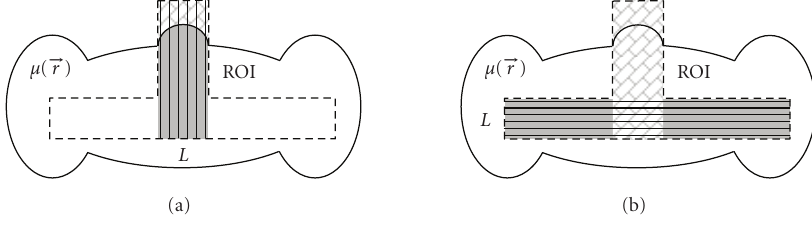
Figure 3: Illustration of the general exact ROI reconstruction approach in the case of a T-shaped ROI. (a) Per the data su ffi ciency condition by Defrise et al., a group of vertical line segments can be exactly and stably reconstructed; and (b) per our new data su ffi ciency condition, a group of horizontal line segments can also be exactly and stably reconstructed using our truncated Hilbert transform technology. The textured regions are known before the involved truncated Hilbert transforms are